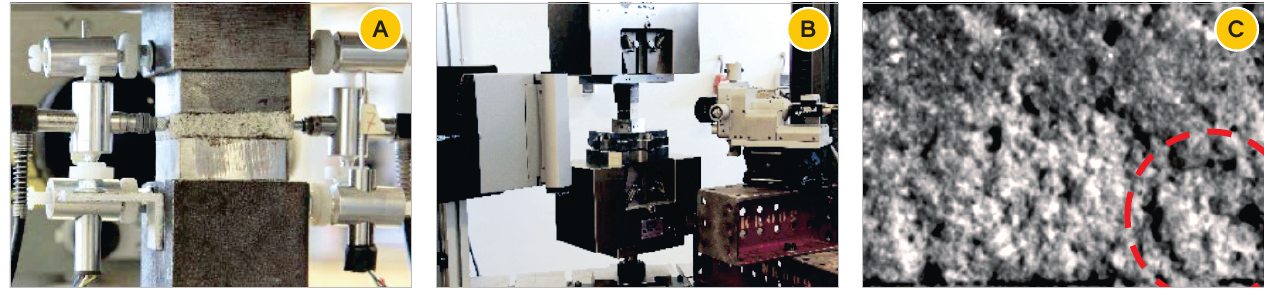
Preliminary tests on mortar